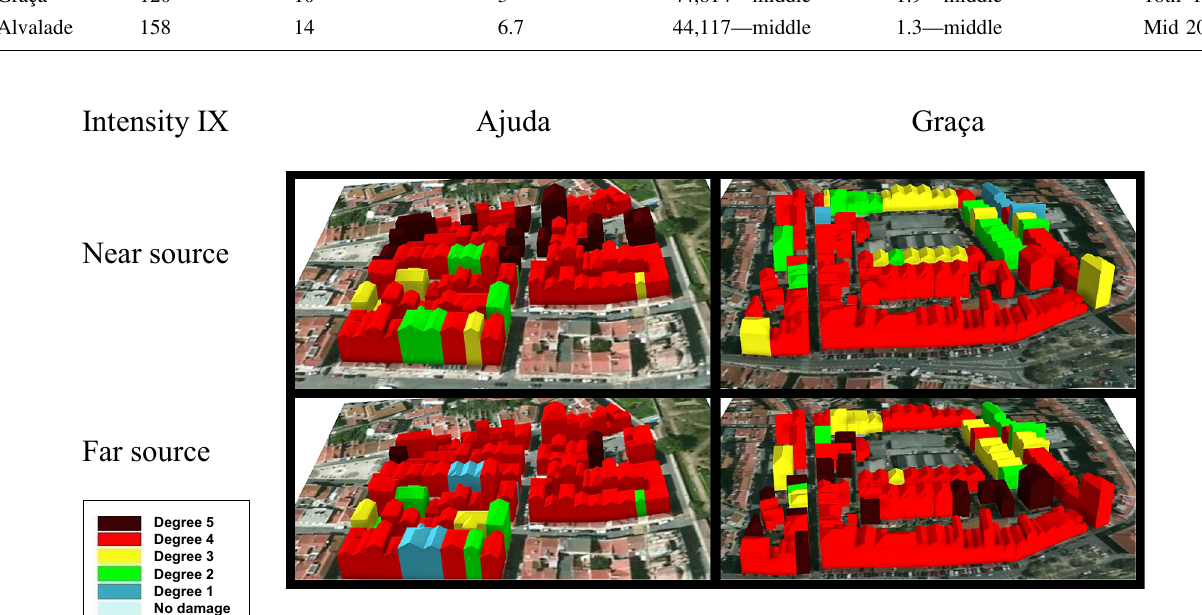
Fig. 7 Comparison between the behavior of buildings in Ajuda and Grac¸a for the same seismic intensity but different sources (color symbology